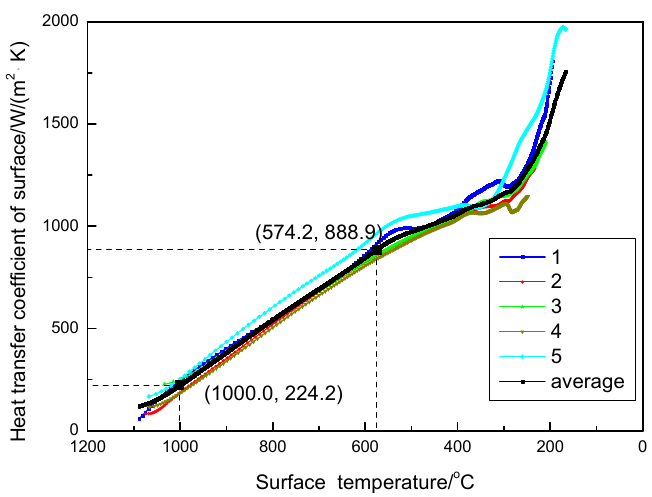
Figure 10. Relationship between surface temperature and HTC.